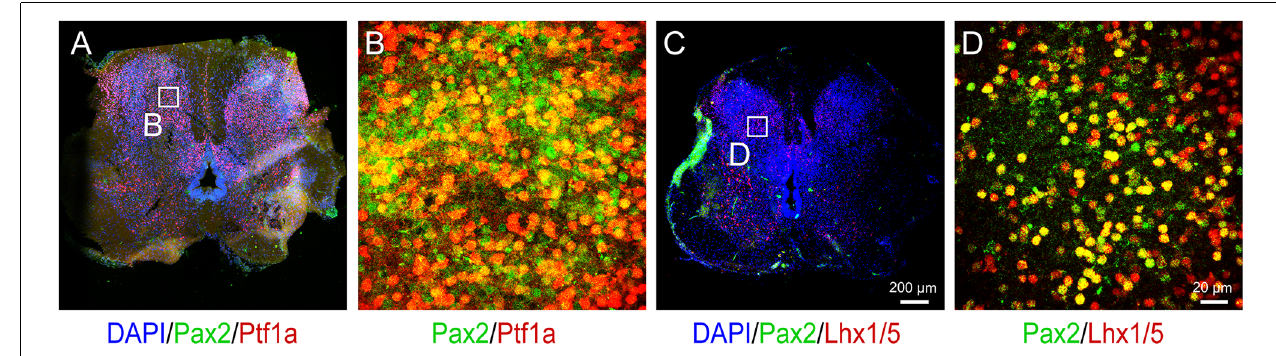
FIGURE 4 | Immunophenotyping of 12-week human embryo spinal cord. (A) Immunostaining for Pax2 and Ptf1a in the spinal cord. Panel (B) is the magnified view on the inset in (A) . (C) Immunostaining for Pax2 and Lhx1/5 in the spinal cord. Panel (D) is the magnified view on the inset in (C) . Scale bar, 200 µ m (A,C) and 20 µ m (B,D)